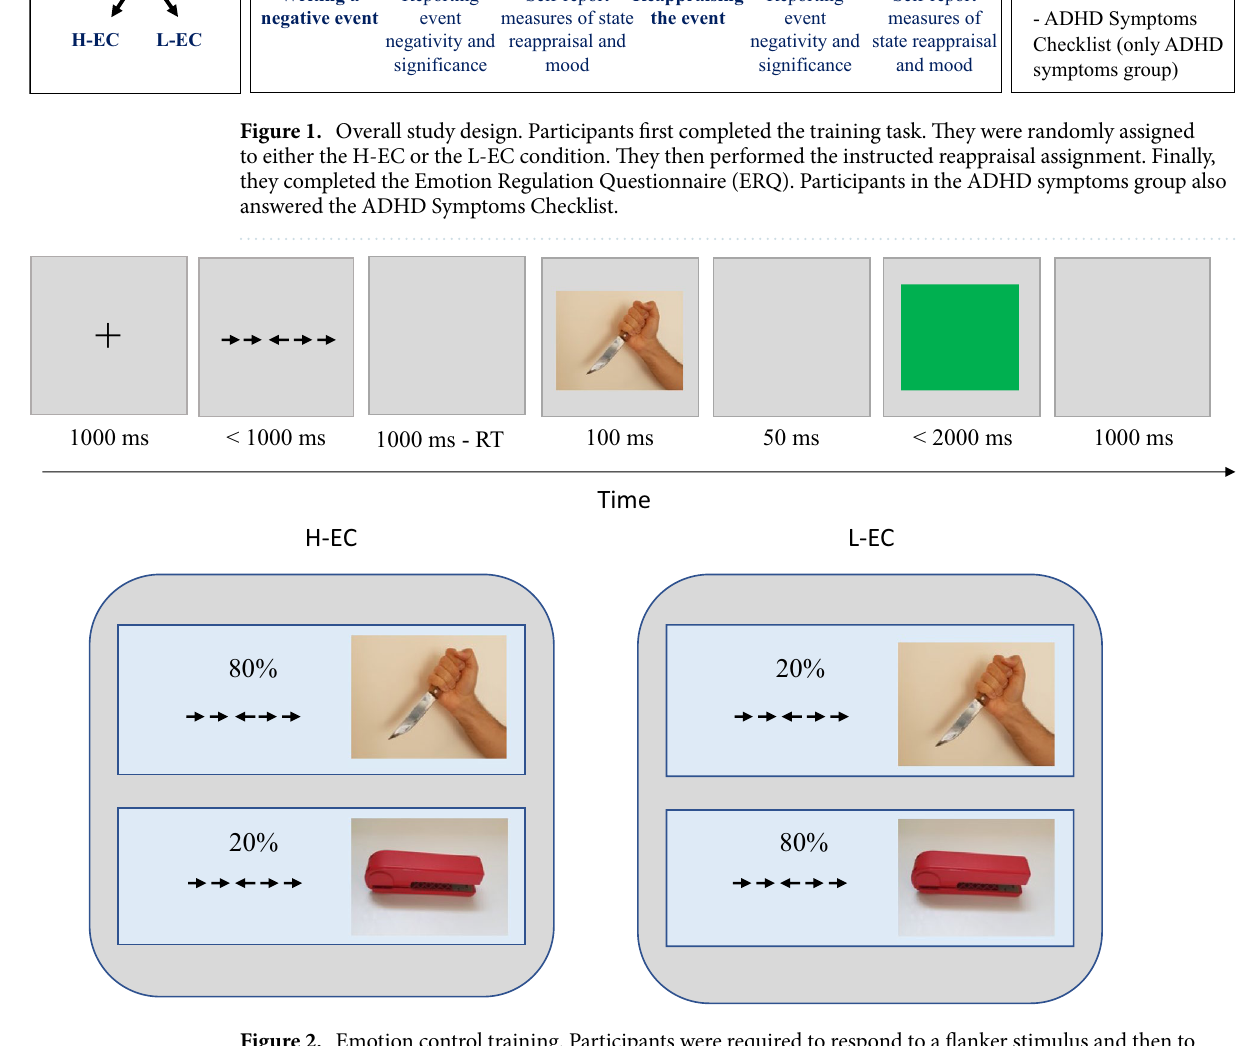
Figure 2. Emotion control training. Participants were required to respond to a flanker stimulus and then to discriminate between a blue and a green square. In the H-EC condition, most (80%) of the negative pictures were preceded by an incongruent flanker stimulus, while in the L-EC condition, most (80%) of the negative pictures were preceded by a congruent flanker stimulus. Illustration images were taken by